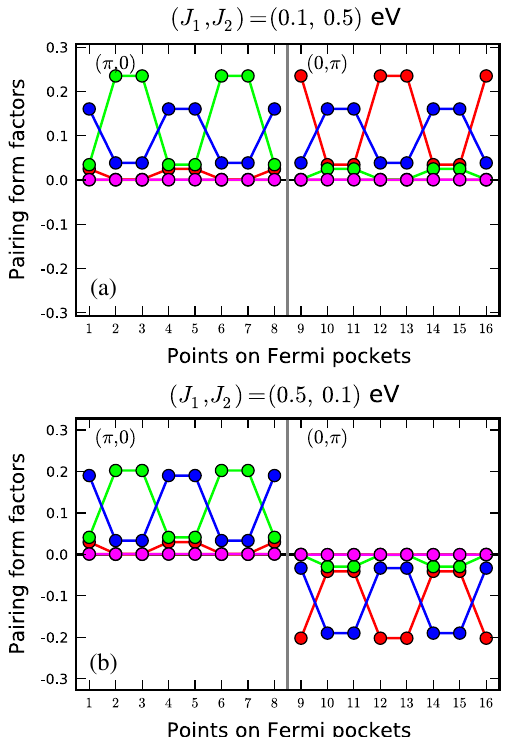
FIG. 12. Orbital-resolved pairing form factors of two typical RG flows. (a) resides in the dominant s -wave regime, (b) in the d -wave regime. The color code is the same as in Fig.